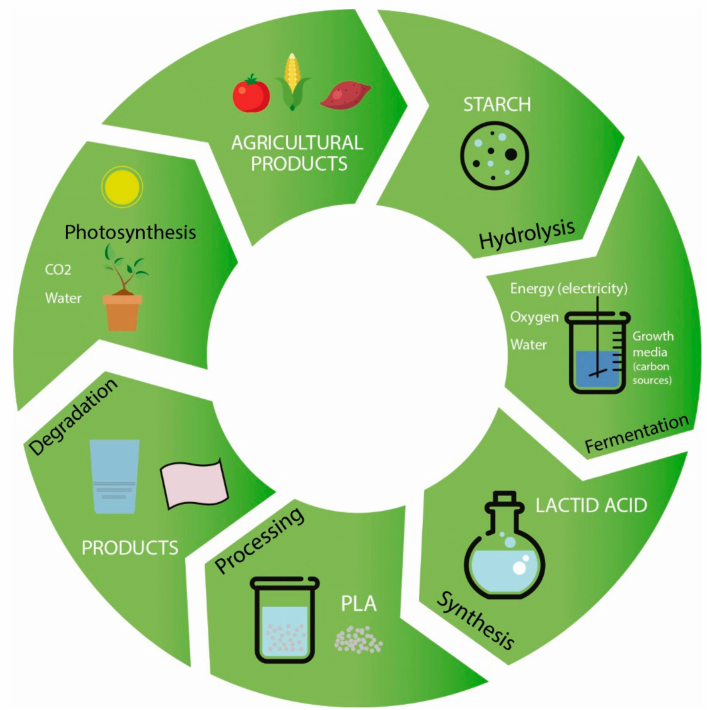
Figure 2. PLA cycle in nature. Adapted from Auras et al. [6], with permission from